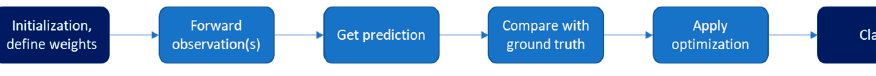
Figure 6. Indicative example of MLP steps.